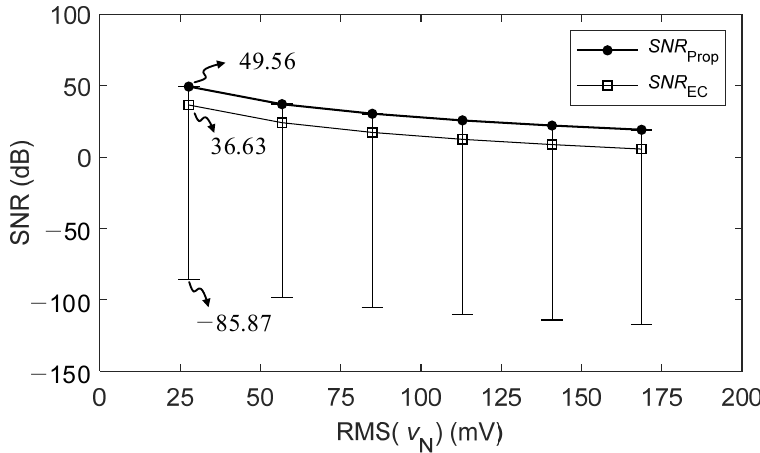
Figure 11. Simulated SNR variation with RMS value of input noise in a conventional monitoring system with the event controller (“EC”), and with the proposed event-driven monitoring system (“Prop”).